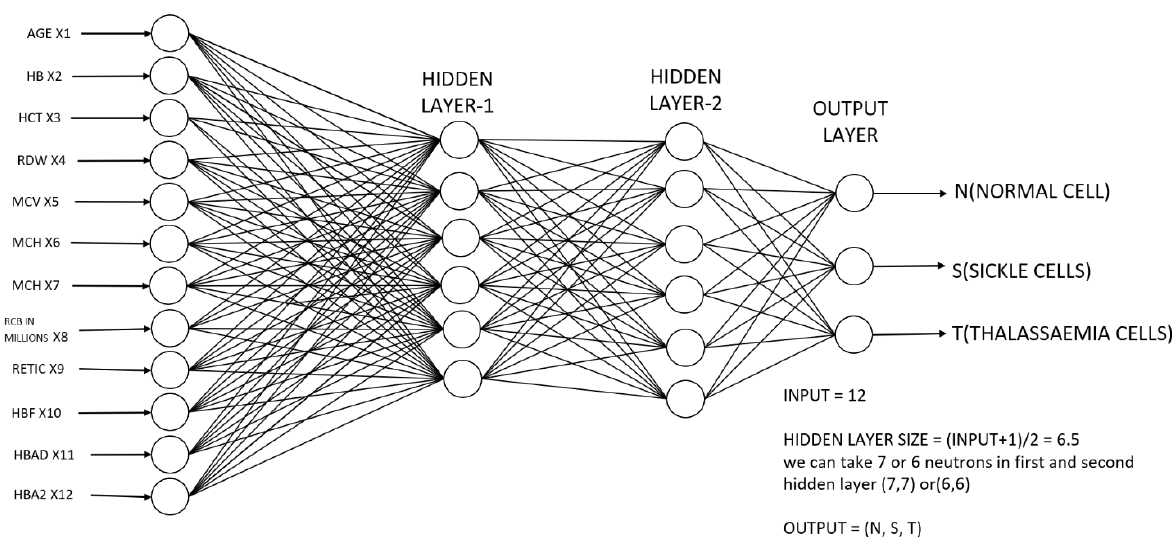
Figure 2. Architecture of the proposed network model for MLP